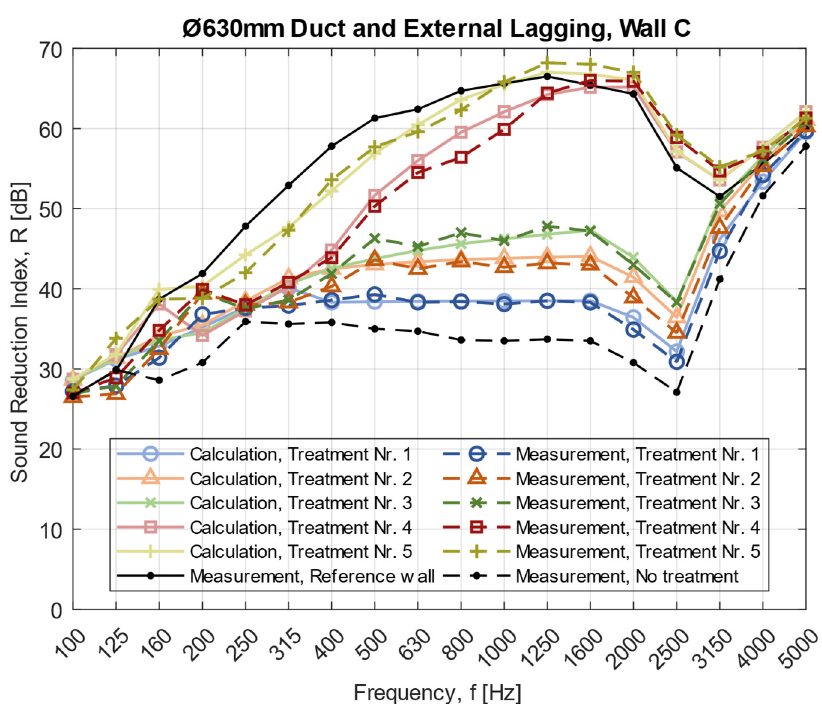
Figure 7. Theoretical models compared to measurements with external lagging as acoustic treatment. Ventilation duct with Ø630 mm through wall C with a sound reduction index of R w = 54 dB. External lagging is mounted at partial lengths of 0.6–1.8 m (Treatment 1–3) and full length (Treatment 4 and 5) with 50 mm and 100 mm stone wool, density of 100 kg/m 3 , closest to the wall.